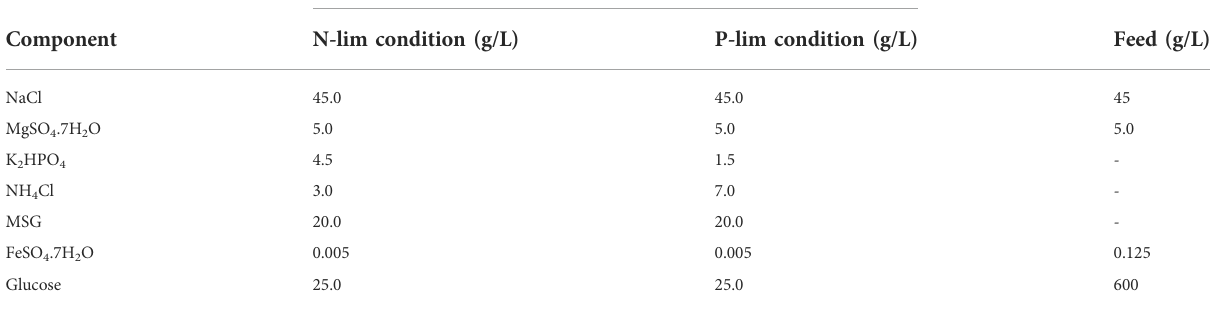
TABLE 1 Composition of the initial medium and feed in fed-batch